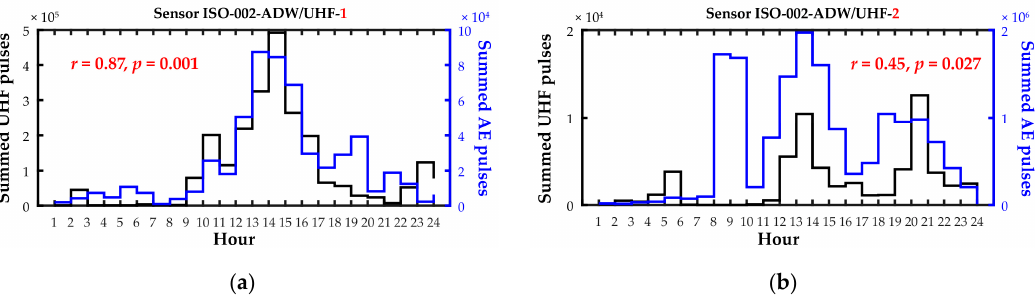
Figure 33. Hourly distribution of the UHF and AE pulses for sensor: ( a ) ISO-002-ADW/UHF-1 and ( b ) ISO-002-ADW/UHF-2.